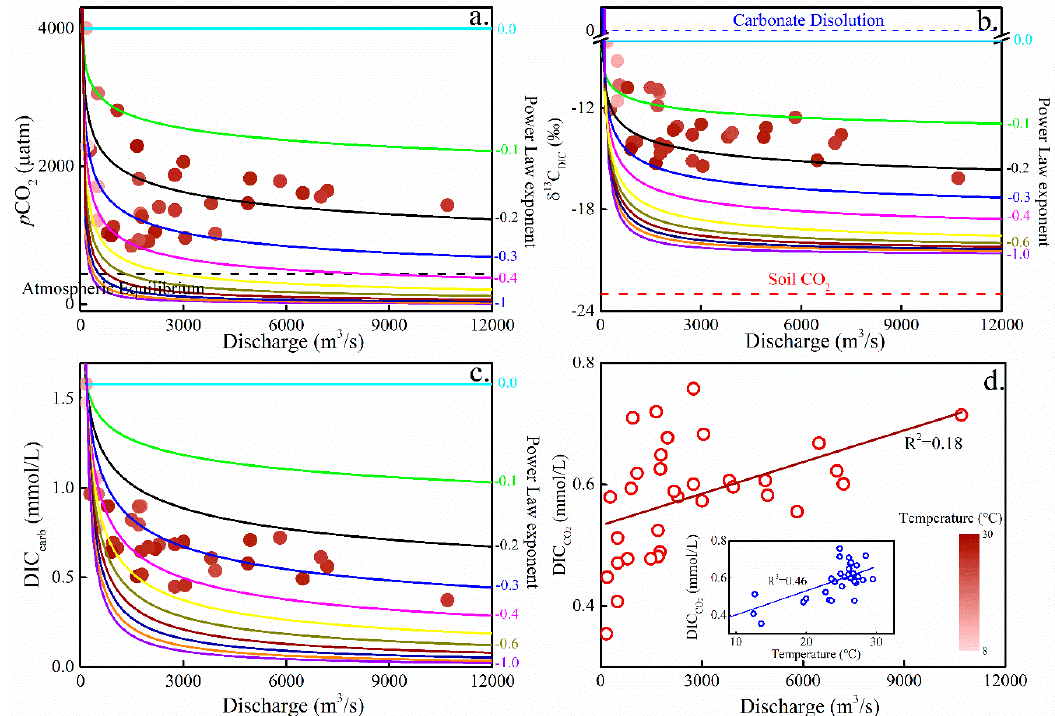
Figure 9. The power–law relationship between p CO 2 and discharge ( a ). δ 13 C DIC values responding with discharge variations ( b ). The power–law relationship between DIC carb and discharge ( c ). The power–law relationship between DIC CO2 and discharge ( d ).